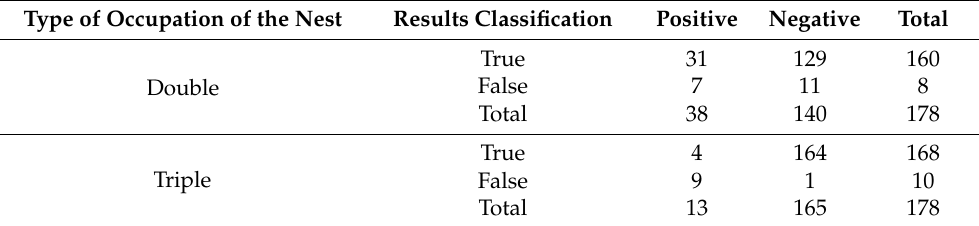
Table 6. Performances of the sensor in the detection of a double or triple occupation of the nest during an oviposition. Type of Occupation of the